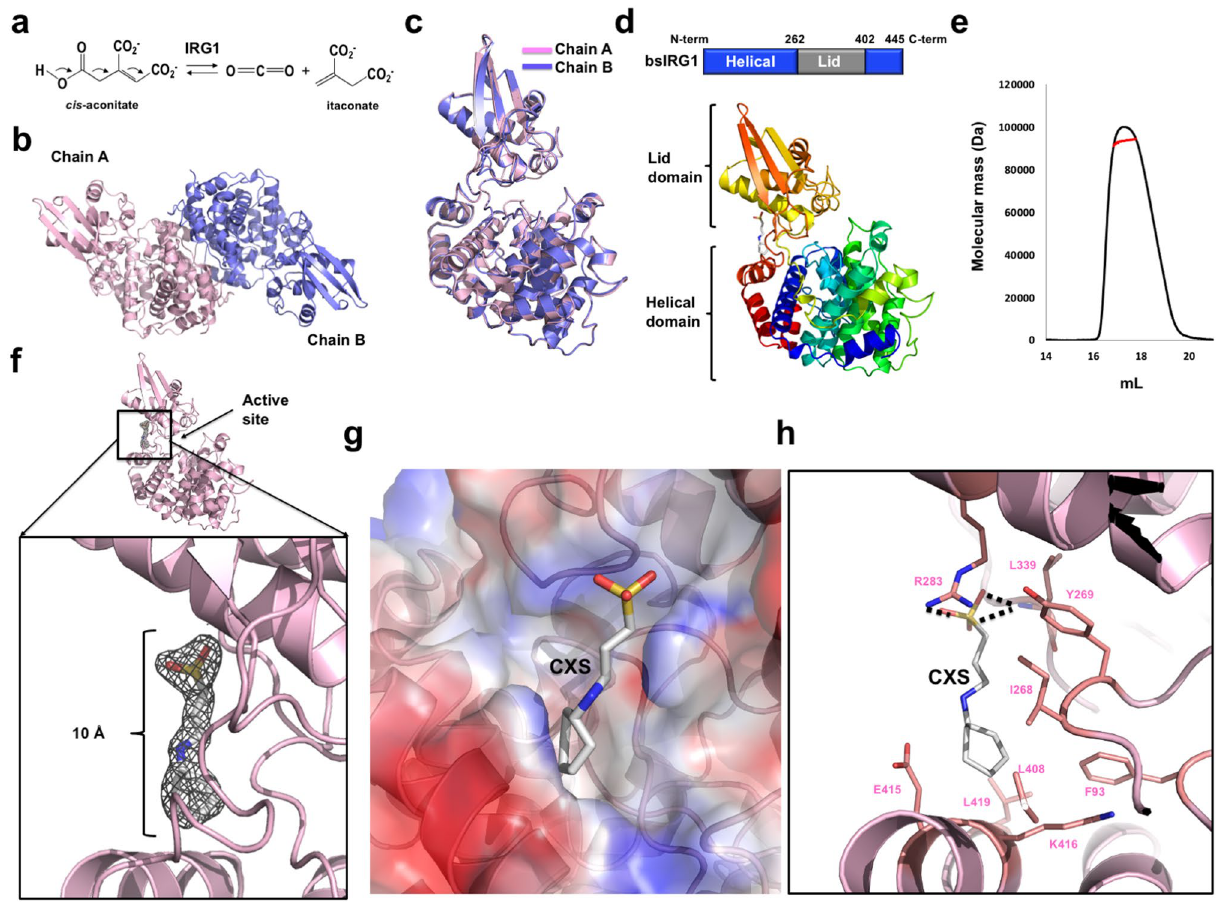
Figure 1. Crystal structure of Bacillus subtilis immune-responsive gene 1 (bsIRG1). ( a ) The production of itaconate catalyzed by IRG1 using cis -aconitate as a substrate. ( b ) Cartoon representation of dimeric bsIRG1. ( c ) Superposition of chain A and chain B of bsIRG1. ( d ) Domain boundary of bsIRG1. The positions of helical domain and lid domain are shown in the bar diagram shown in the upper panel. The rainbow-colored cartoon representation of monomeric bsIRG1 is shown in the lower panel. The peptide from the N- to C-termini is colored blue to red. ( e ) Multi-angle light scattering profile. Red line indicates the experimental molecular mass. ( f ) Unidentified electron density assigned as 3-cyclohexyl-1-propylsulfonic acid (CXS). 2Fo-Fc density map contoured at the 1σ level around CXS is shown. The magnified view is presented in the lower panel. ( g ) Electrostatic surface representation around the CXS binding pocket of bsIRG1. ( h ) Binding details between CXS and bsIRG1. Amino acid residues from bsIRG1, which are involved in the interaction with CXS, are labeled. Black dashed lines indicate hydrogen